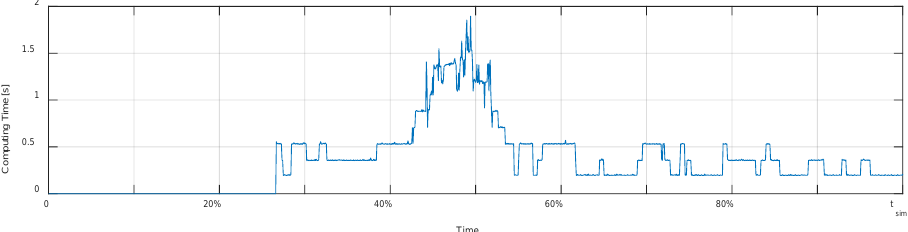
Figure 21. Example of application of NMPC to the startup of a LP turbine, computing time.